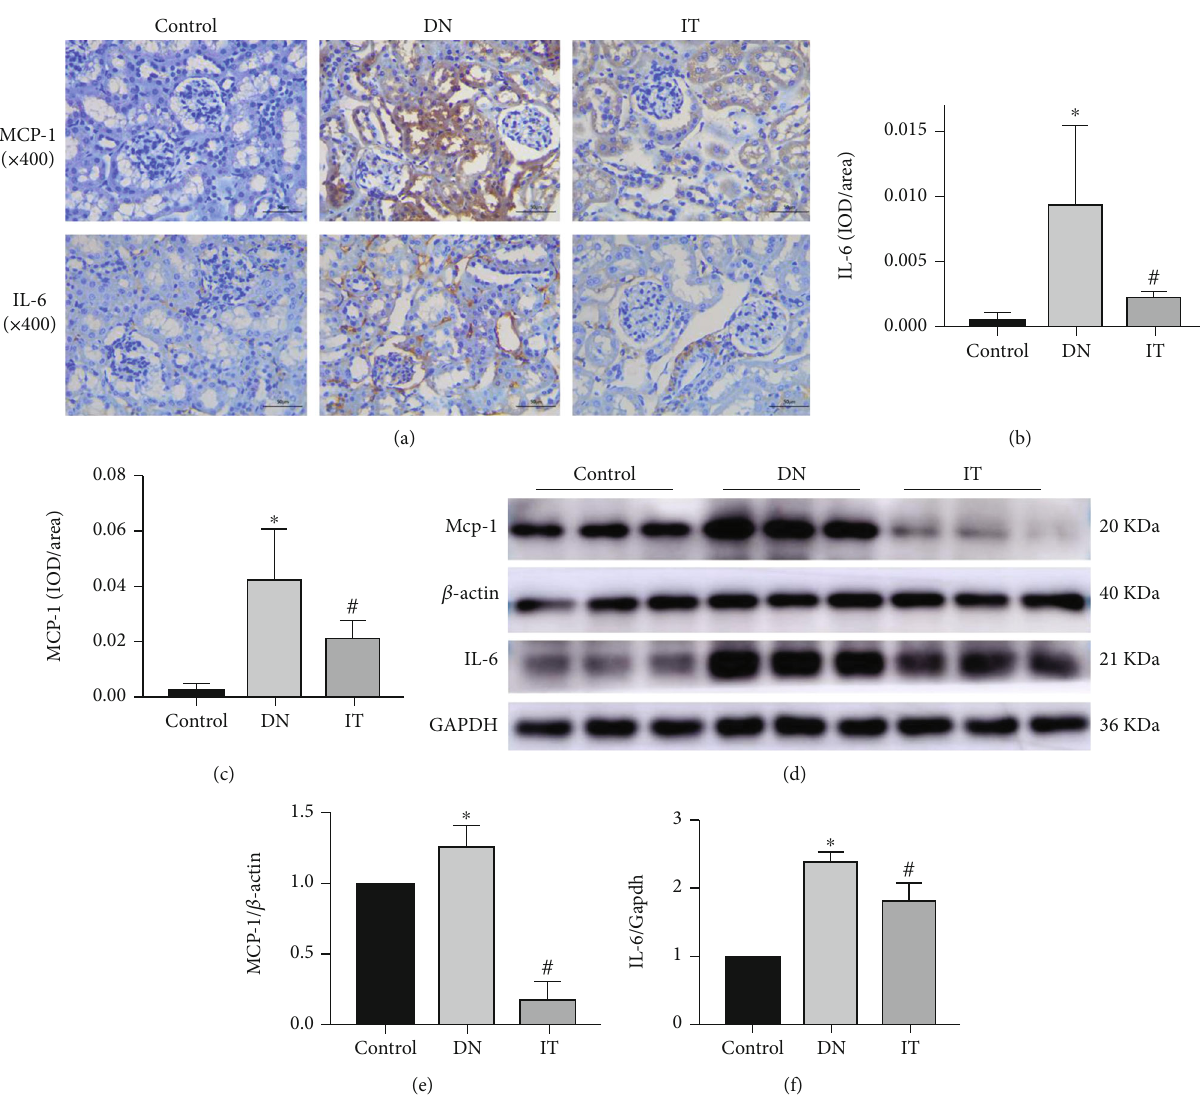
Figure 3: Islet transplantation inhibited the expression of in fl ammatory factors in diabetic nephropathy mice. (a – c) Immunohistochemical staining ( × 400) and quantitative analysis showing the expression levels of IL-6 and MCP-1 in di ff erent groups. Quanti fi cations of IL-6 and MCP proteins expression in the kidney was measured by mean integrated optical density (IOD)/area. (d – f) Levels of IL-6 and MCP-1 proteins were quanti fi ed by western blot analysis. There are three replicates in each group ( ∗ P < 0 : 05 versus the control group, # P < 0 : 05 versus the DN